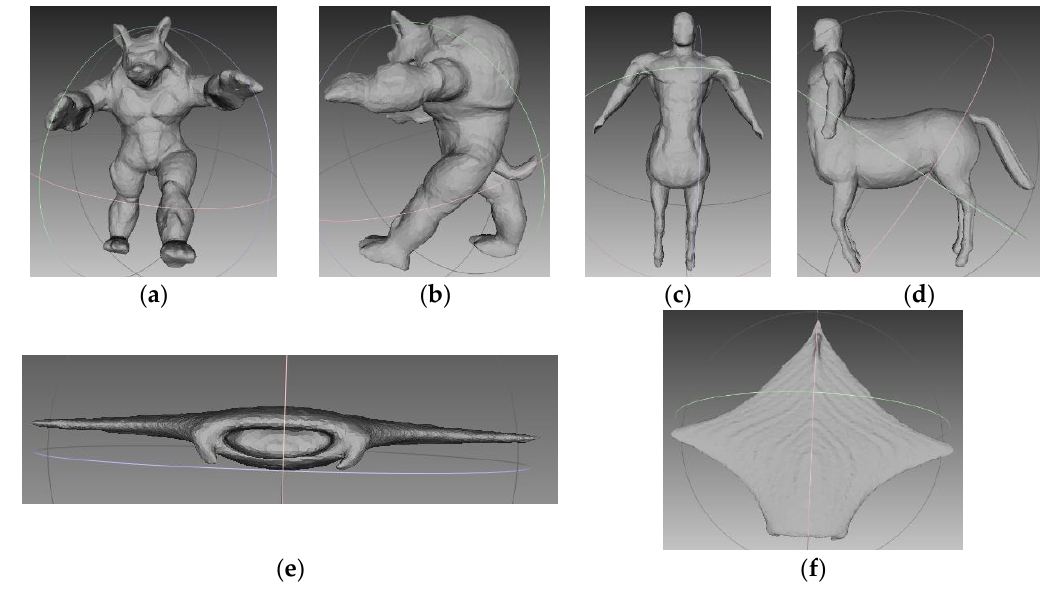
Figure 11. Models in SHREC 2015 benchmark. ( a ) Front of the armadillo; ( b ) Side of the armadillo; ( c ) Front of the centaur; ( d ) Side of the centaur; ( e ) Front of the manta ray; ( f ) Top of the manta ray.